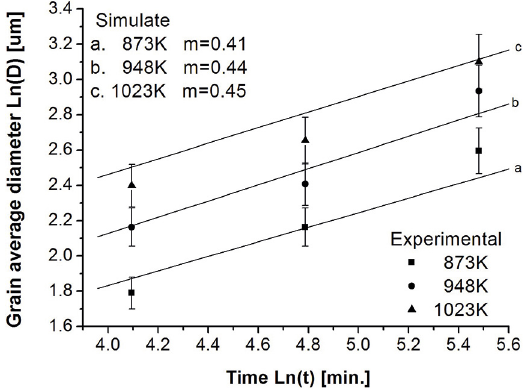
Figure 5: Temporal evolution of average grain diameter during growth at each isothermal treatment temperature.